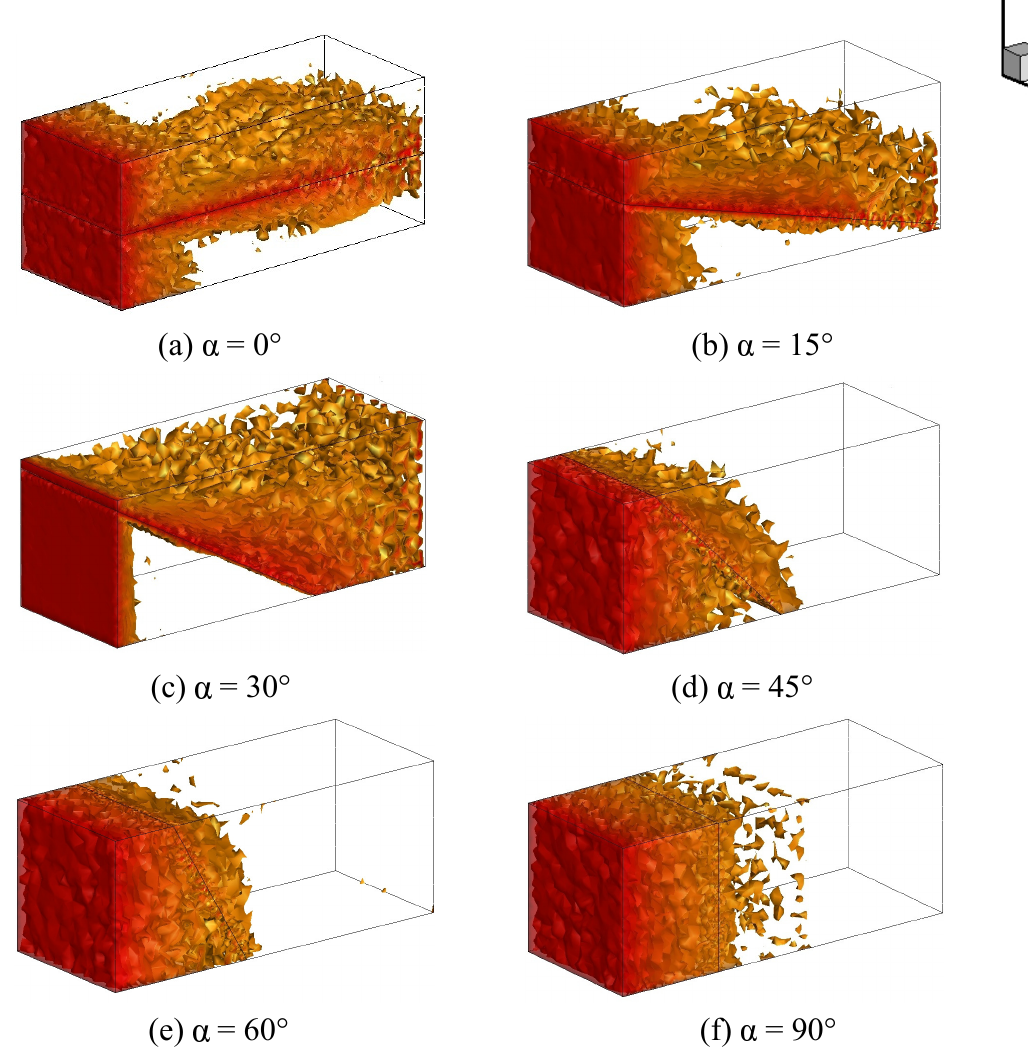
Figure 9. Grout penetration with a single fracture at different inclination angles in the porous medium considering the filtration